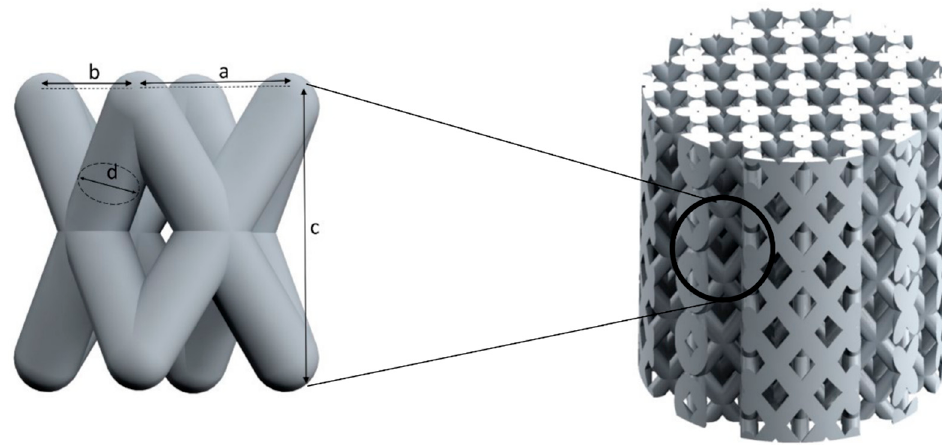
Figure 2. Unit cell (twisted design) and a large scaffold of diameter, D , and height, H , for mechanical testing—here as an example for the representation of the test body design.